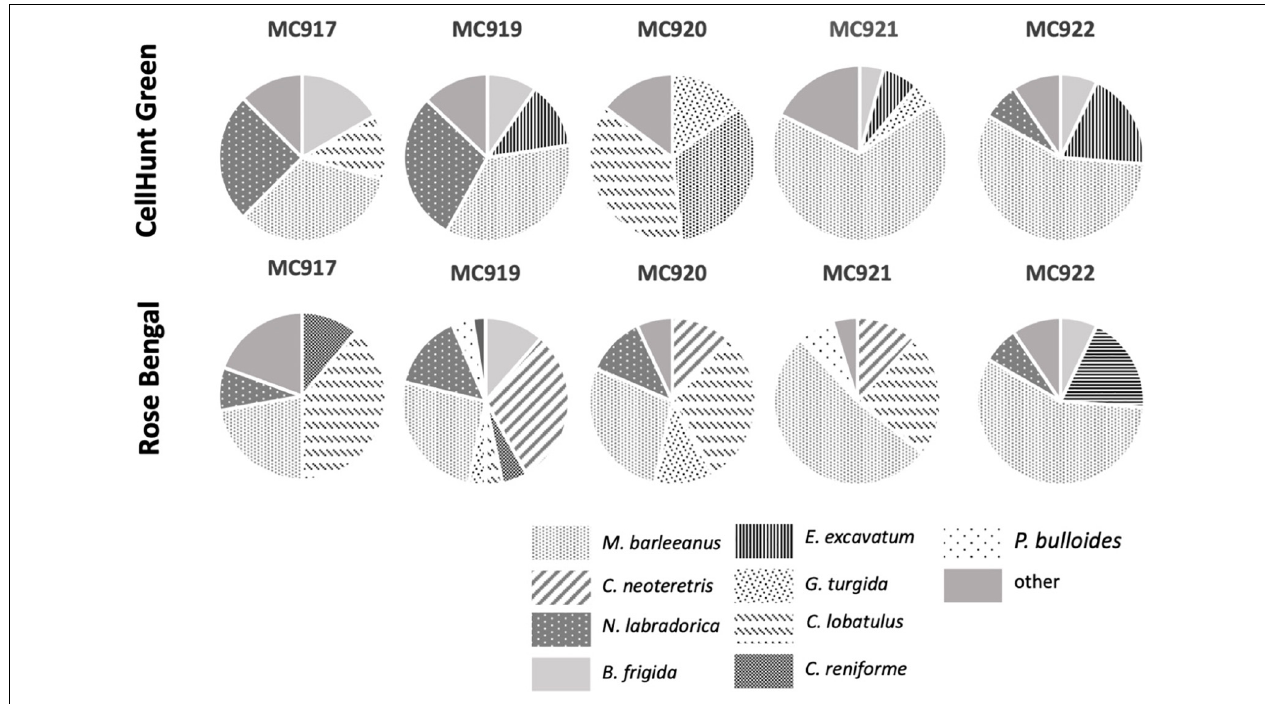
FIGURE 8 | Foraminiferal species composition within the active GHP1 (MC917 and MC919) and post- active GHP5 (MC920, MC921, and MC922). CellHunt Green labeled samples (upper panel) and Rose Bengal stained (lower panel) .